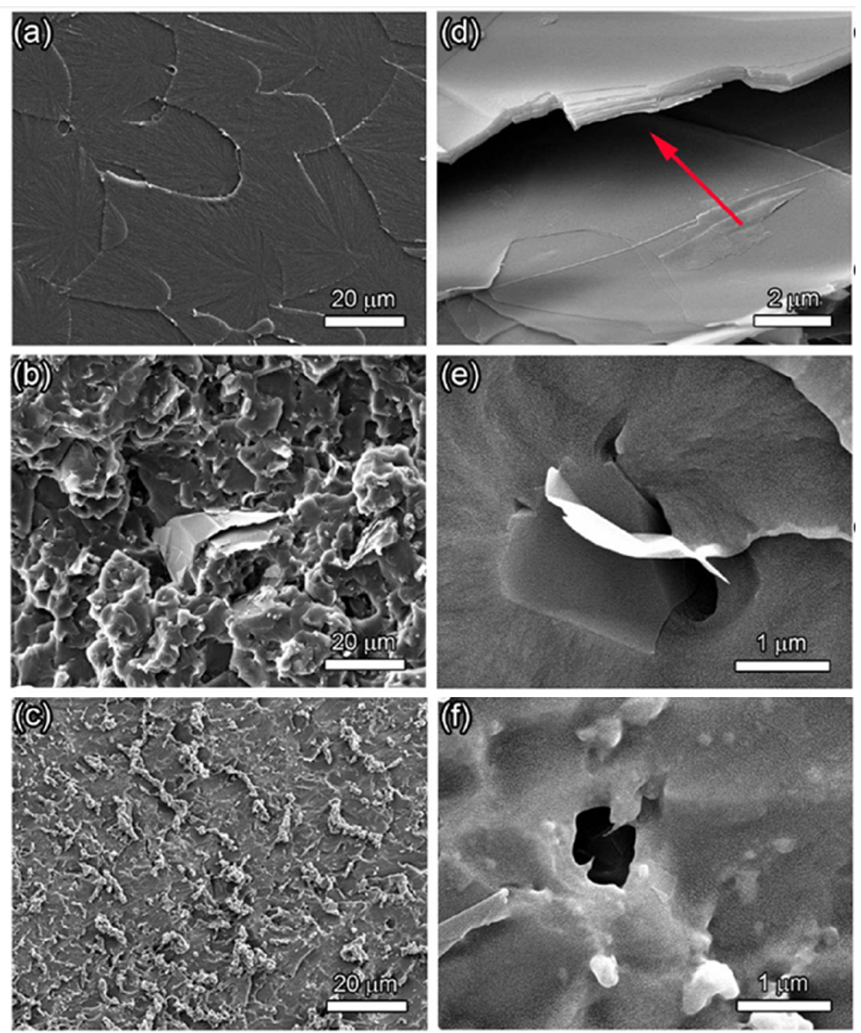
Figure 11. Mechanical characterization and morphology of 1.0 wt.% graphene–epoxy composites. ( a – c ) SEM images of fracture surfaces of epoxy resin, ultrasonic treated nanocomposites, and the (HP and ultrasonic) treated nanocomposites, respectively. ( d ) High magnification image of graphene block in ( b ) The big gap between the graphene sheets, as indicated by the arrow in (d), implies that the graphene sheets slide over each other during the bending test. ( e , f ) High magnification images of wrinkled and bridging graphene in ( c ). Reproduced with permission from Nature Publishing group [164] (CC BY).